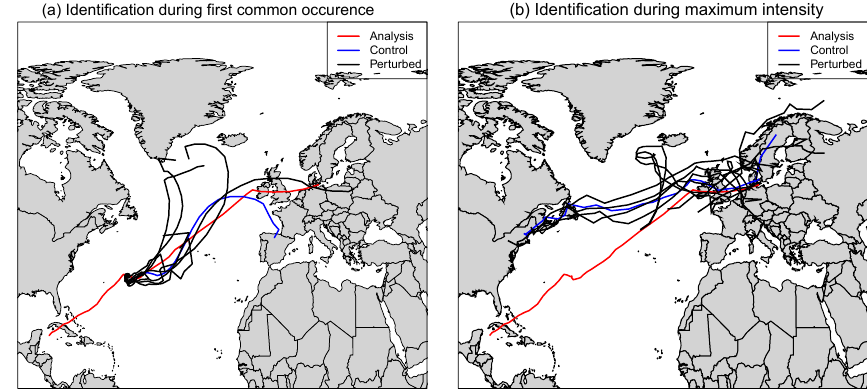
Figure 2. Example of the identified tracks of ex-hurricane Lili in the 6-day ensemble reforecast initialised on 22 October 1996 closest to ERA- Interim during the 24h period of first common occurrence on 22 October (a) and of maximum intensity in ERA-Interim on 28 October (b)